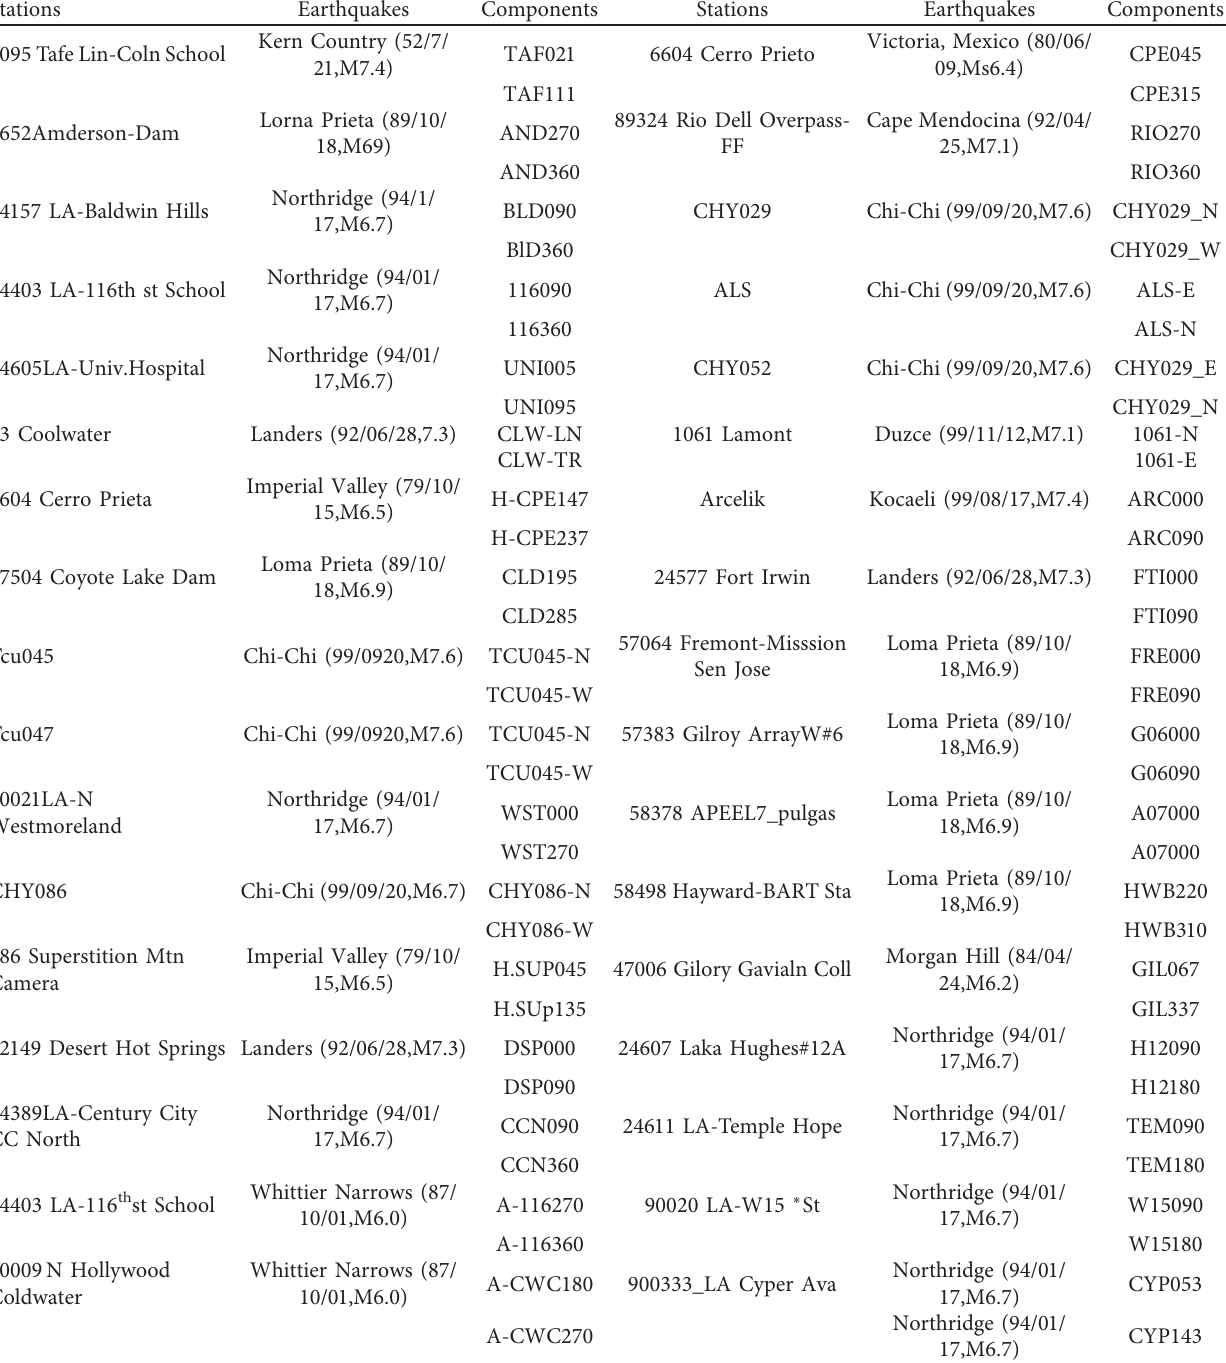
Table 1: The ground “A” records for HSS (34